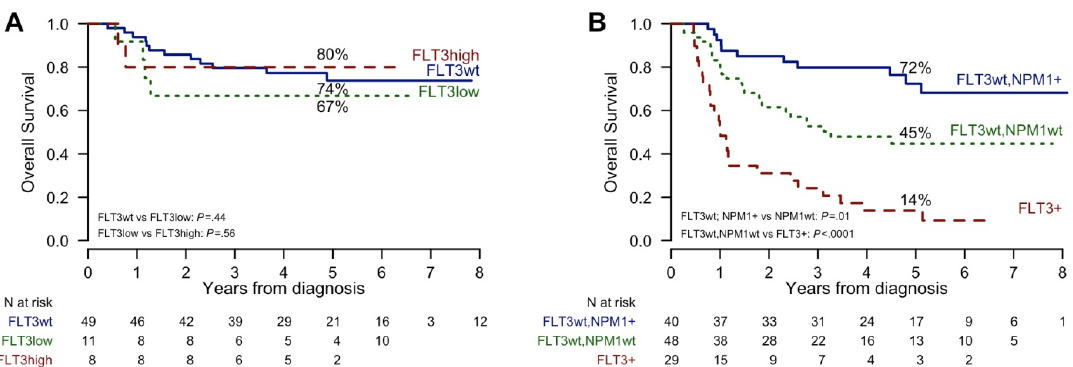
Figure 6. Kaplan-Meier curves of Overall Survival (OS) in di ff erent consolidation programs. ( A ) Patients